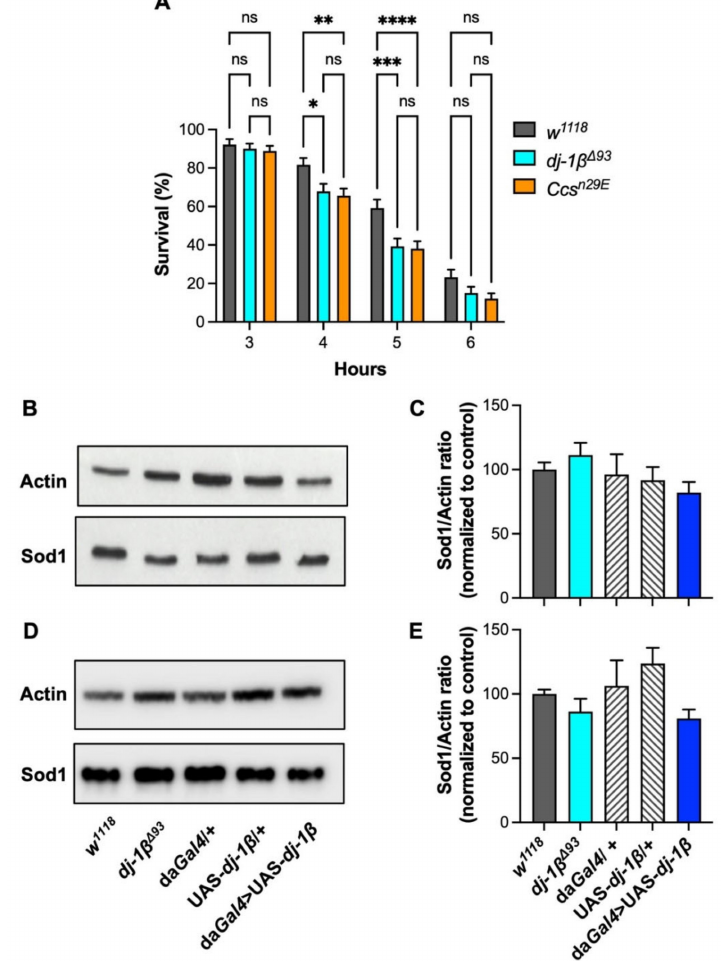
Figure 2. dj-1 β protects against oxygen deprivation without affecting Sod1 expression: ( A ) Percentage of survivors (mean ± SEM) in dj-1 β ∆ 93 , Ccs n29E , and w 1118 control flies, after 3, 4, 5, and 6 h of anoxic treatment. dj-1 β ∆ 93 and Ccs n29E flies showed significantly higher mortality as compared with w 1118 controls after 4 and 5 h of anoxia. Anoxia induced similar effects in both dj-1 β ∆ 93 and Ccs n29E flies, at all time points (two-way ANOVA (time of treatment X genotype) F 6, 1578 = 1.28, p = 0.263; time of treatment effect: F 3, 1578 = 222.4, p < 0.0001; genotype effect: F 2, 1578 = 13.83, p < 0.0001; in the graph ****, ***, **, *, and ns indicate p < 0.0001, < 0.001, < 0.01, < 0.05, and non-significant, in Tukey’s multiple comparisons post-hoc tests, see text for details); ( B ) representative Western blot and ( C ) relative quantification of Sod1 protein levels (mean ± SEM) under basal conditions, in dj-1 β KO and dj-1 β -overexpressing (da Gal4 > UAS- dj-1 β ) flies as compared with controls ( w 1118 , da Gal4 /+ and UAS- dj-1 β /+); in ( C ), Sod1 levels are reported as the Sod1/Actin ratio, with Actin signal used as a loading control. No significant differences in Sod1 protein signals were detected among genotypes (one-way ANOVA F 4, 23 = 0.90, p = 0.483, N > 4 per genotype); ( D ) representative Western blot and ( E ) relative quantification of Sod1 protein levels (mean ± SEM) in dj-1 β KO and dj-1 β -overexpressing (da Gal4 > UAS- dj-1 β ) flies as compared with controls ( w 1118 , da Gal4 /+, and UAS- dj-1 β /+ ), after 7